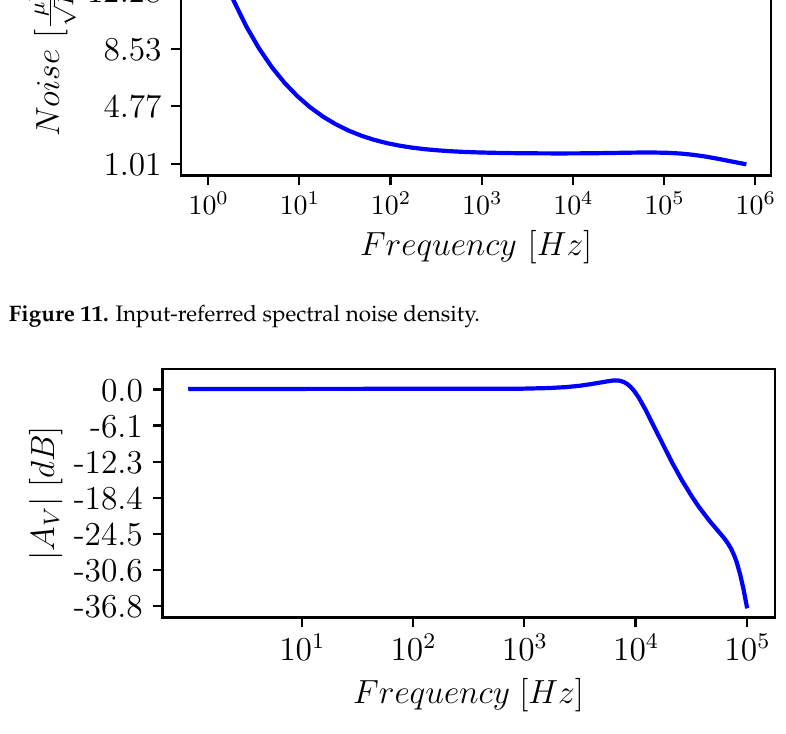
Figure 12. Frequency response of the OTA in unity-gain configuration.